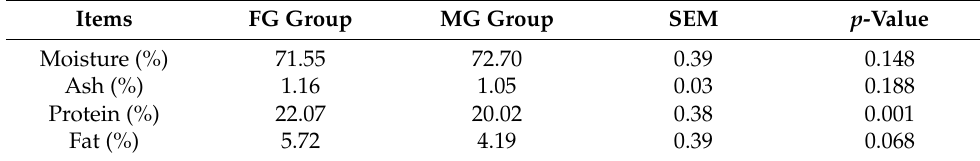
Table 4. Nutritional traits of longissimus thoracis (LT) muscle of goats in two groups. Items FG Group MG Group SEM p -Value Moisture